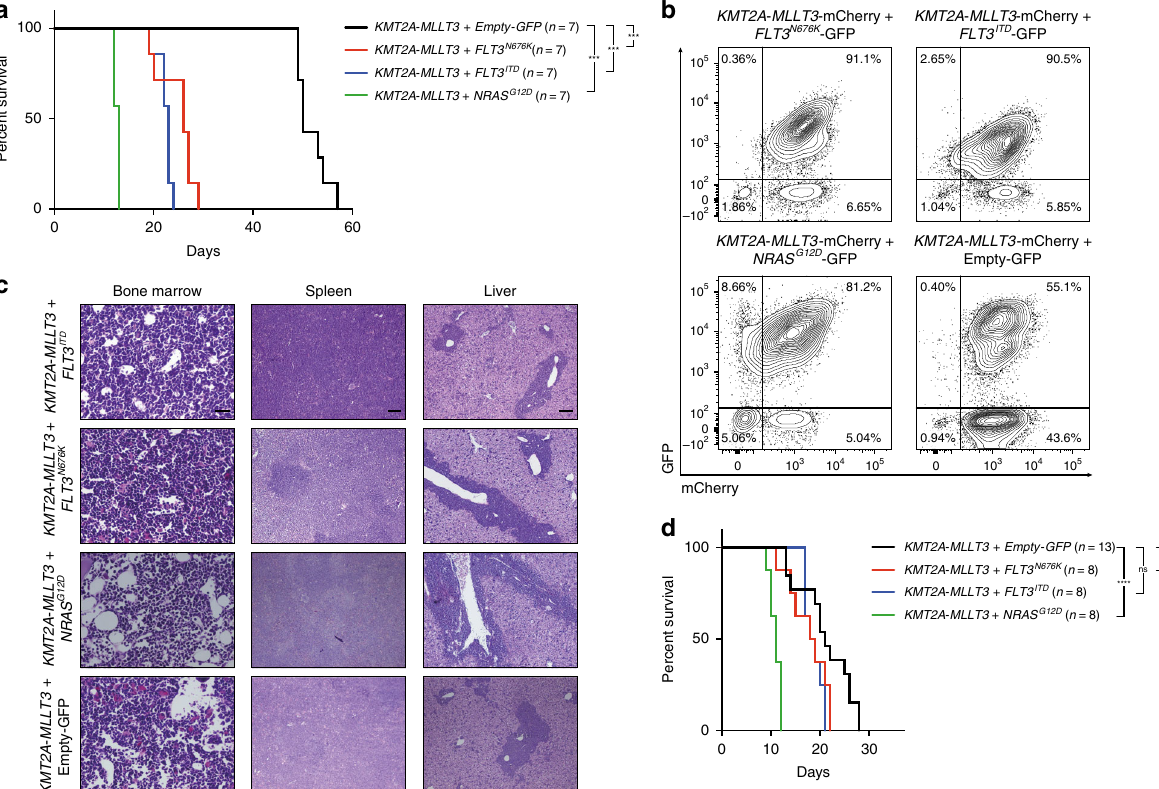
Fig. 1 FLT3- and RAS-signaling mutations accelerate AML onset. a Kaplan – Meier survival curves of mice transplanted with bone marrow (BM) cells co- transduced with KMT2A-MLLT3 and either FLT3 ITD , FLT3 N676K , or NRAS G12D ( n = 7 for all groups), showing accelerated disease onset for mice receiving KMT2A-MLLT3 and either of the activating mutations ( P = 0.0002 for KMT2A-MLLT3 + FLT3 ITD , P = 0.0002 for KMT2A-MLLT3 + FLT3 N676K , and P = 0.0004 for KMT2A-MLLT3 + NRAS G12D , as compared to KMT2A-MLLT3 + Empty-GFP. Mantel – Cox log-rank test). b Flow cytometric analysis of BM from sacri fi ced mice showed that a majority of cells were GFP + mCherry + in mice co-expressing KMT2A-MLLT3 and an activating mutation. c Hematoxylin – eosin stained sections from bone marrow, liver, and spleen (original magni fi cation 200×, scale bar 0.1 mm, for bone marrow and 40×, scale bar 0.5 mm, for spleen and liver). The architecture of the spleen is effaced and the red pulp is expanded mainly due to expansion of immature myeloid cells. In the liver, periportal, perisinusoidal and intrasinusoidal extensive in fi ltrates of immature hematopoietic cells were noted. d Kaplan – Meier curves for secondary recipients transplanted with primary leukemic splenocytes showing that only KMT2A-MLLT3 + NRAS G12D sustained a signi fi cant difference in disease latency when compared to KMT2A-MLLT3 + Empty-GFP ( P < 0.0001. Mantel – Cox log-rank test). *** P ≤ 0.001, **** P ≤ 0.0001; ns, not signi fi